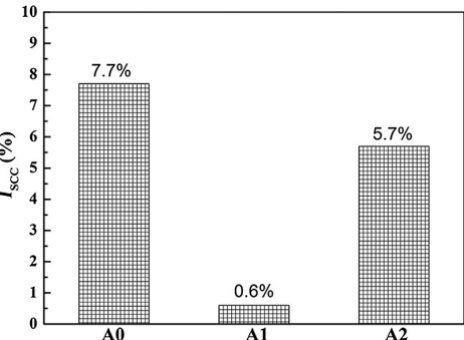
Figure 3. SCC susceptibility index (ISCC) of three peak-aged alloys. For Al Zn Mg alloys with 0 wt% Sc (A0), 0.06% Sc (A1) and 0.11% SC (A2)After homogenization treatment (470 °C for 24h), the ingot is preheated at 450 °C for 1H. Adapted with permission from ref. [41]. 2018 Li et al.